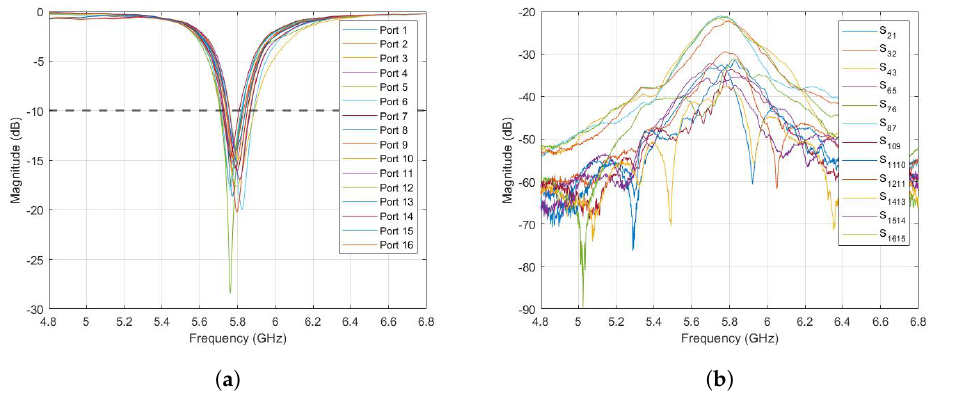
Figure 10. Experimental results of the phased array designed for wireless power transfer containing the return loss of each element ( a ) and the coupling between elements of the same row ( b ).